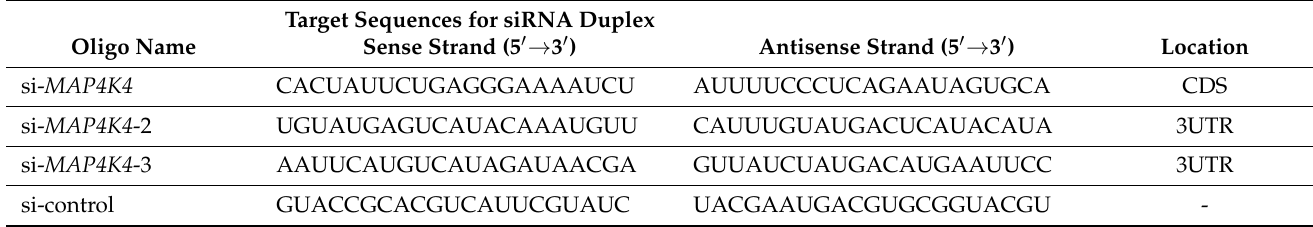
Table A2. siRNA sequences of three kinds of siRNAs for MAP4K4 (si-MAP4K4), and that of con-trol siRNA (si-control). Target Sequences for siRNA